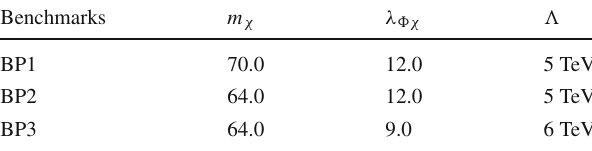
Table1 Thebenchmarkpointsfor γγ + / E T finalstate.Wehavechosen f 1 = f 2 = 1 for all the